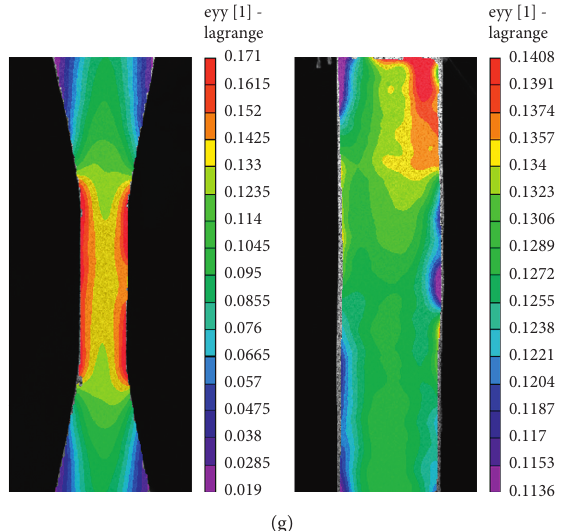
Figure 3: Longitudinal strain field during tensile testing. (a) 0 ° . (b) 15 ° . (c) 30 ° . (d) 45 ° . (e) 60 ° . (f) 75 ° . (g) 90 °